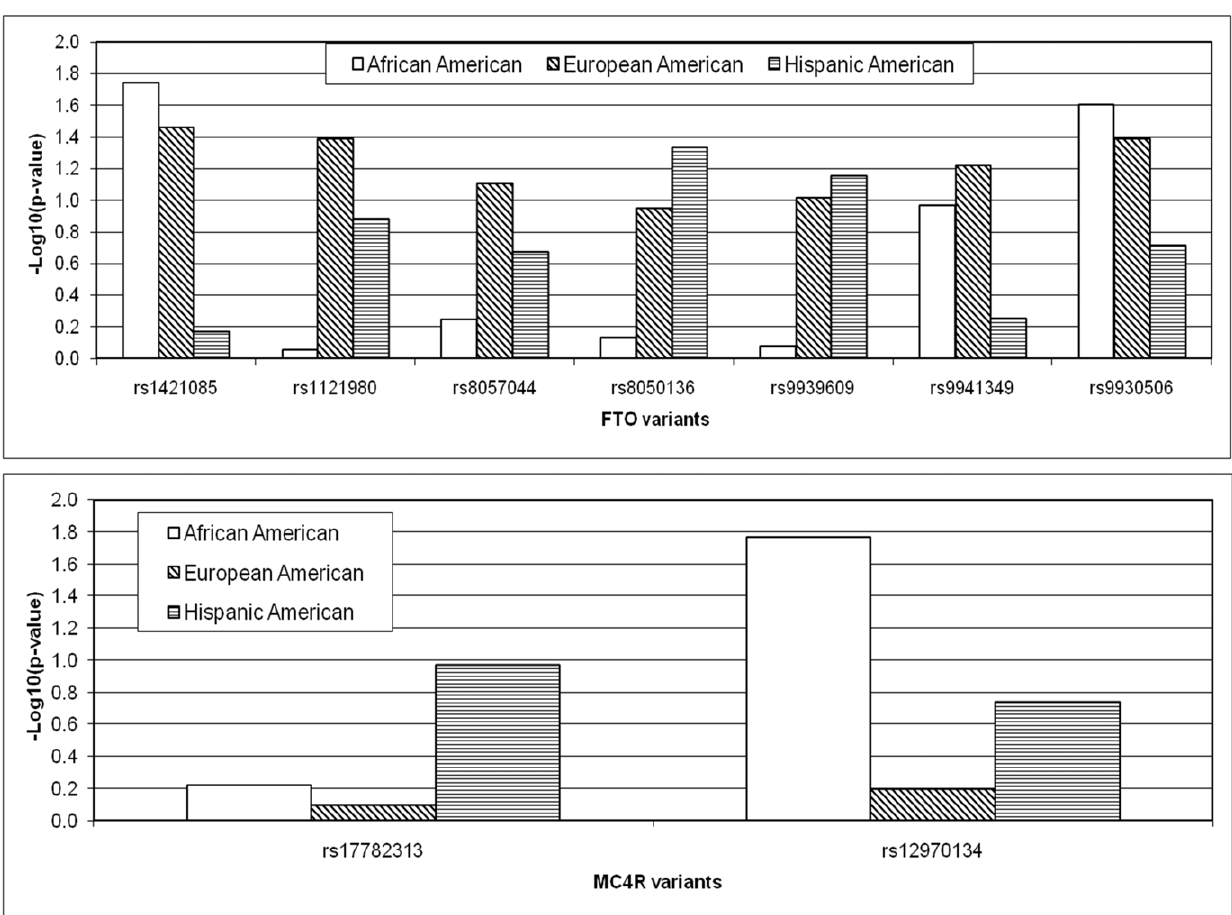
Figure 7. BMI associations with published obesity variants in FTO (Top) and MC4R (Bottom) genes in the three biobank samples.